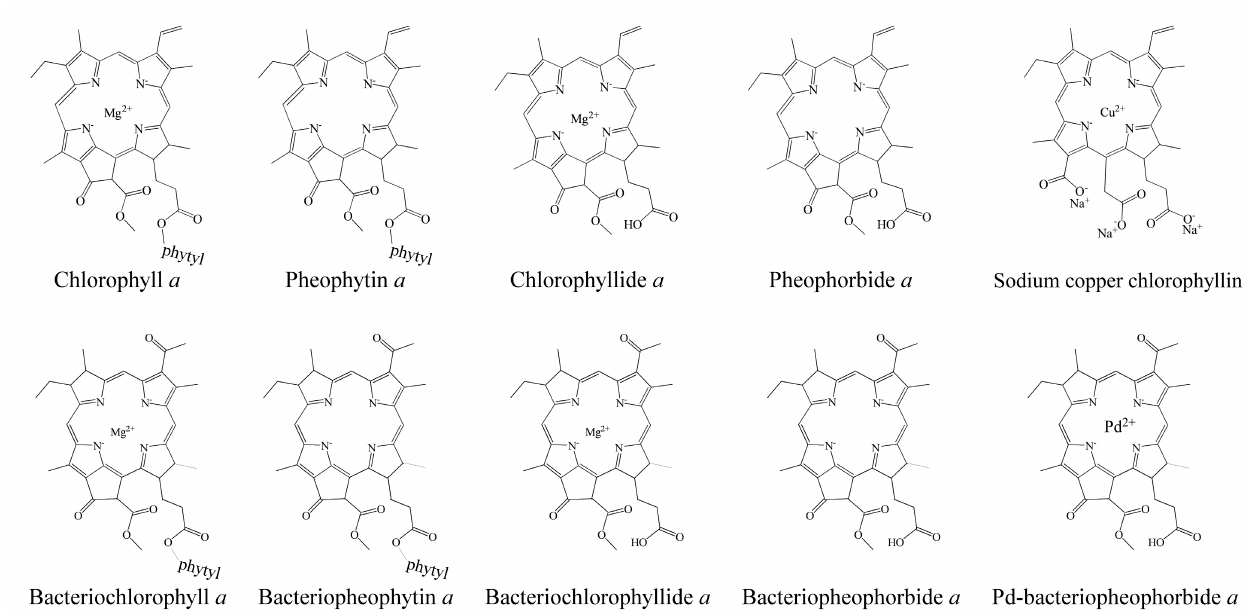
Figure 1. The compounds relative to bacteriochlorophyllides.